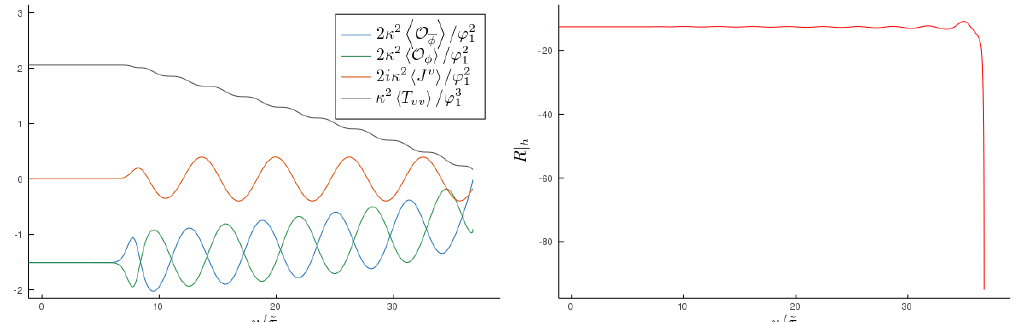
Figure 6: (Top) Expectation values 2.22 for a quench with profile 3.3 and parameters ξ = 0, A = 0.2, ω = 1 / ( 4 π ) , v = 2.5 and τ = 0.25. This corresponds to non- i m Hermitian oscillations around the Hermitian point. (Bottom) Evolution of the Ricci scalar at the apparent horizon for the same simulation as in top . It diverges at the end as a consequence of the shrinking of the apparent horizon, which gets us too close to the interior